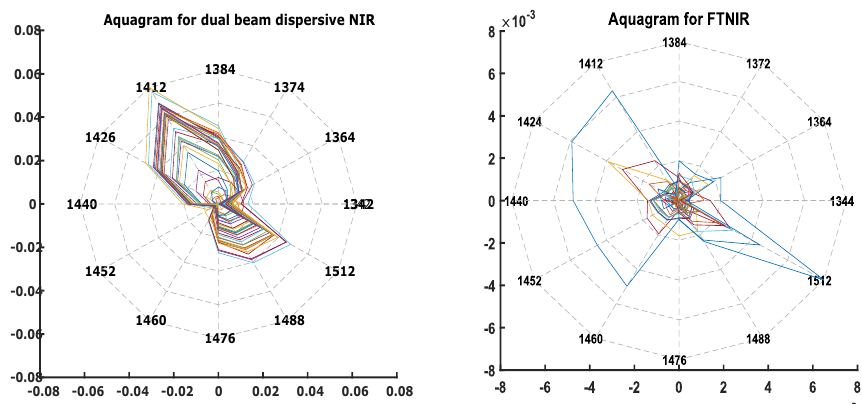
Figure 2. Aquagrams for lactate in whole blood samples in Water Absorbance Bands (WAB) 1300–1600 nm, showing Water Absorbance Spectral Pattern (WAPS) in the Water matrix co-ordinates (WAMACS) of varying concentrations of lactate in PBS samples. The WAMACS: C 1 : 1342 (1344), C 2 : 1364, C 3 : 1374 (1372), C 4 : 1384, C 5 : 1412, C 6 : 1426 (1424), C 7 : 1440, C 8 : 1452, C 9 : 1460, C 1 0: 1476, C 11 : 1488 and C 12 : 1512 nm depicts molecular conformations which arises due to water-NIR light-lactate molecule interactions. The Aquagram on the left is constructed from the dual beam dispersive NIR spectra data-set and the one on the right is constructed from FTNIR spectra